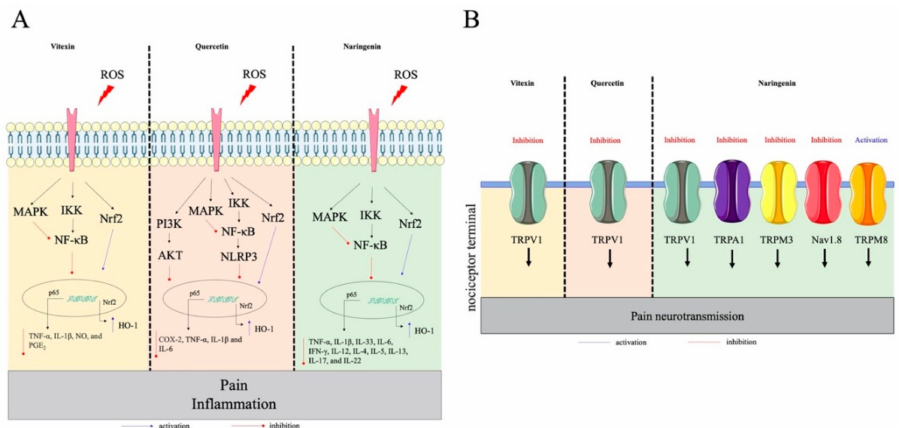
Figure 4. The anti-inflammatory and analgesic e ff ects of Vitexin, Quercetin, and Naringenin. ( A ) Intracellular targets of Vitexin : MAPK [51], NF- κ B [51] and Nrf2 [52], Quercetin : MAPK [53], NF- κ B [53–55], AKT [56], Nrf2 [33,54], and NLRP3 [57] and Naringenin: NF- κ B [58–60] and Nrf2 [59, 61,62]. ( B ) Ion channels expressed by neurons that are targeted by Vitexin, Quercetin, and Naringenin to reduce pain. Vitexin : TRPV1 [38], Quercetin : TRPV1 [63], and Naringenin: TRPV1 [58], TRPA1 [58], TRPM3 [64], Nav 1.8 [65], and TRPM8 [64]. In panel ( A ), ROS and inflammatory stimuli that activate specific receptors trigger intracellular signaling that will result in pain and inflammation. The blue arrows indicate endogenous pathways that are stimulated by flavonoids, and the red arrows represent endogenous pathways that are inhibited by flavonoids resulting in reduced pain and